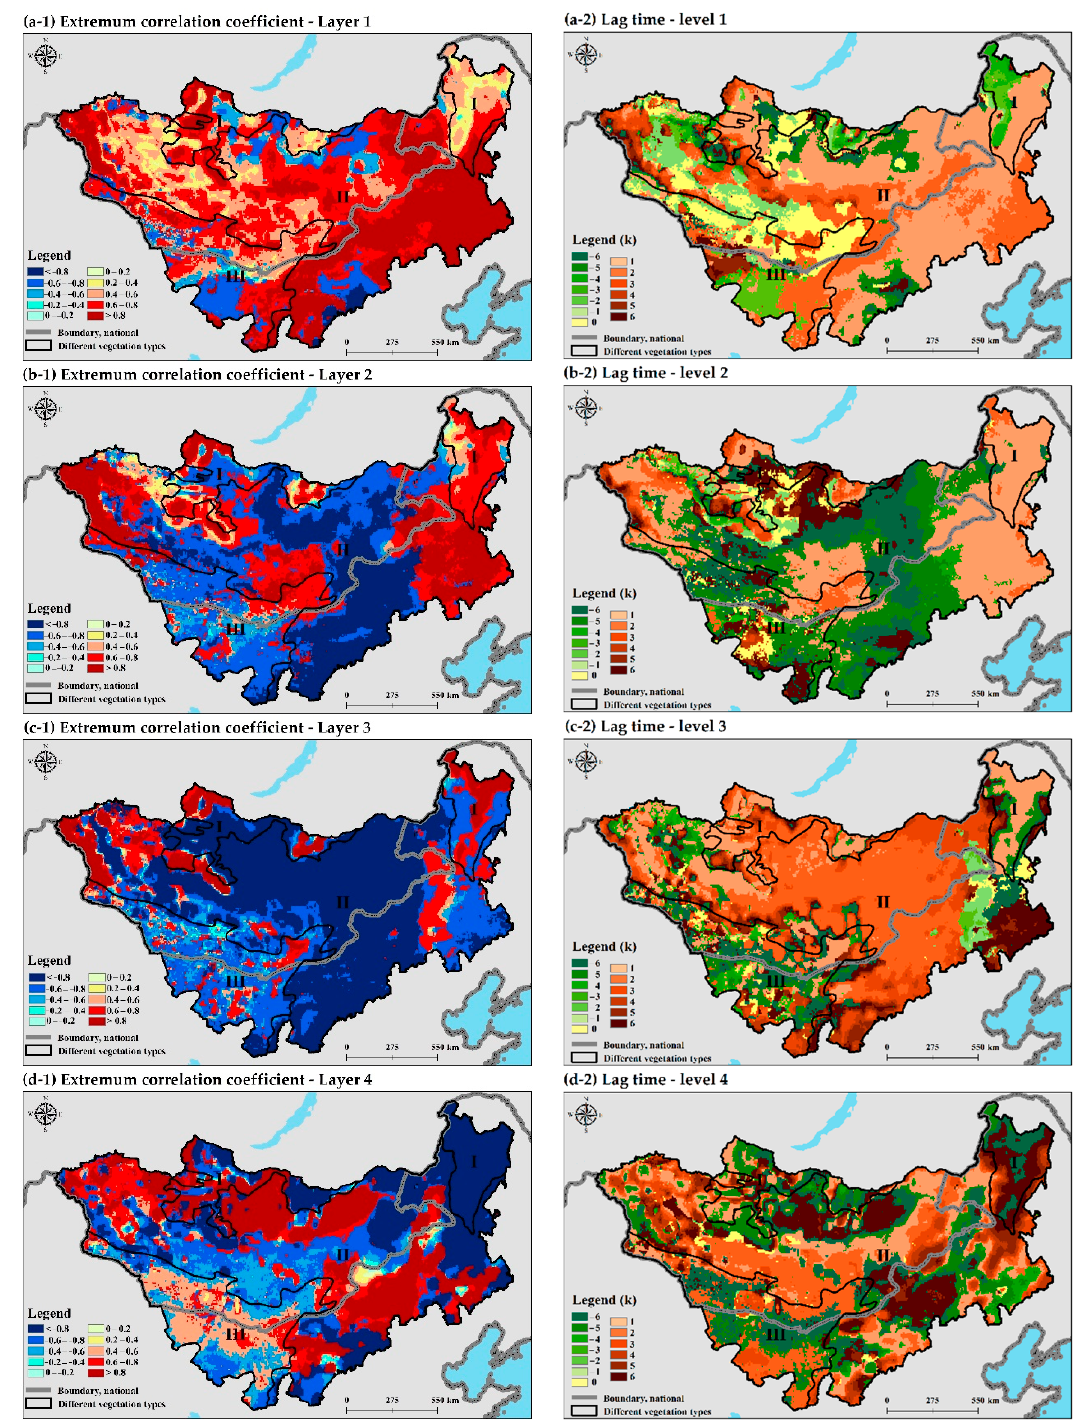
Figure 5. Spatial distribution of the extremum correlation coefficients ( a-1 , b-1 , c-1 , d-1 ) and lag time ( a-2 , b-2 , c-2 , d-2 ) between the NDVI and soil moisture at various depths across the MP.